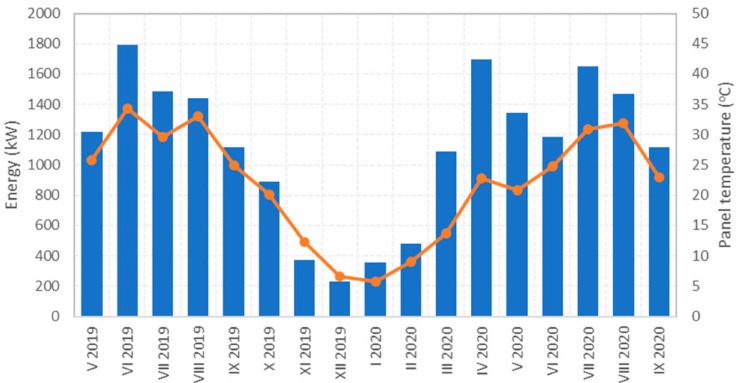
Figure 7. Power output and panel temperature.